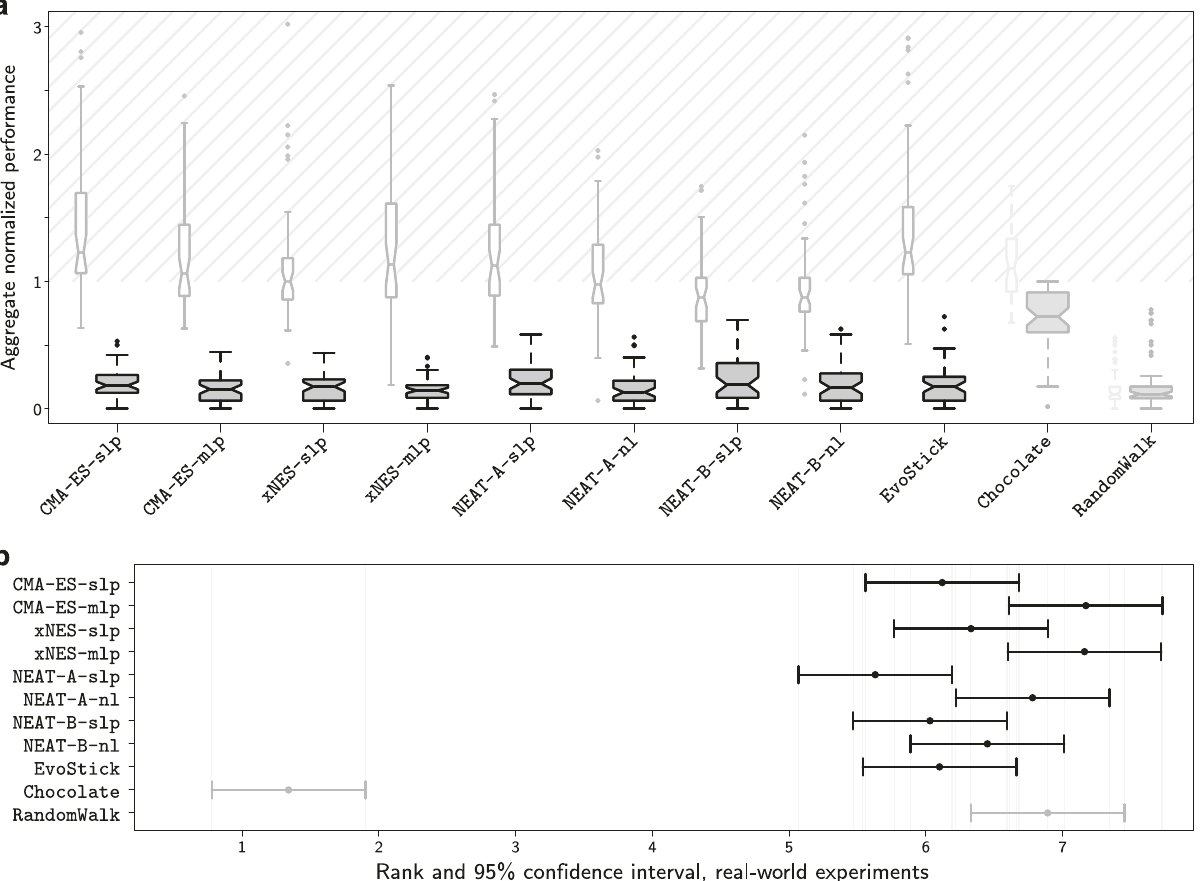
Fig. 3 Aggregated results. a Aggregate performance in simulation (white narrow boxes) and in reality (gray wide boxes) across the fi ve missions considered, represented by notched box-and-whisker plots, where the notches represent the 95% con fi dence interval on the median. If notches on different boxes do not overlap, the medians of the corresponding methods differ signi fi cantly, with a con fi dence of at least 95%. Graphical conventions adopted in box-and-whisker plots are described in “ Methods ” under the heading Statistics. Prior to the aggregation and for each missions, the results are normalized between the lowest and highest performance observed in reality by any of the design methods. As a result, the normalized performance in reality ranges between 0 and 1, but the one in simulation might exceed 1 (shadowed area). Indeed, in many cases, the performance observed in simulation exceeded the best one observed in the real-robot experiments. The performance of Chocolate and RandomWalk , the two methods included in the study as yardsticks, is grayed out so as to focus the attention of the reader to the neuro-evolutionary methods under analysis. b Friedman rank-sum test on the performance in reality: expected rank and 95% con fi dence interval. If two segments do not overlap, the rank of the corresponding methods differ signi fi cantly, with a con fi dence of at least 95%. Also here, the performance of Chocolate and RandomWalk is grayed out to focus the attention to the neuro-evolutionary methods. The videos of all robot experiments are available as Supplementary Movie 1 –